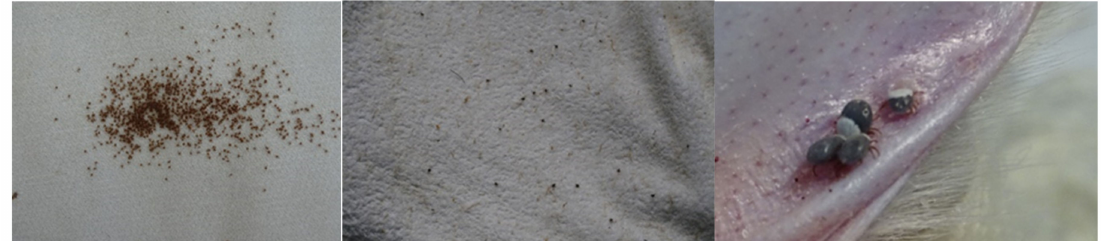
Figure 1. Hyalomma larvae nest (left) may be occasionally collected by dragging in open field. Host seeking Hyalomma lusitanicum nymphs (center) may also be collected by dragging, but not very often because they are usually endophilic. However Hyalomma marginatum is diphasic and larvae molt on the host (right) in consequence unfed nymphs cannot be found by